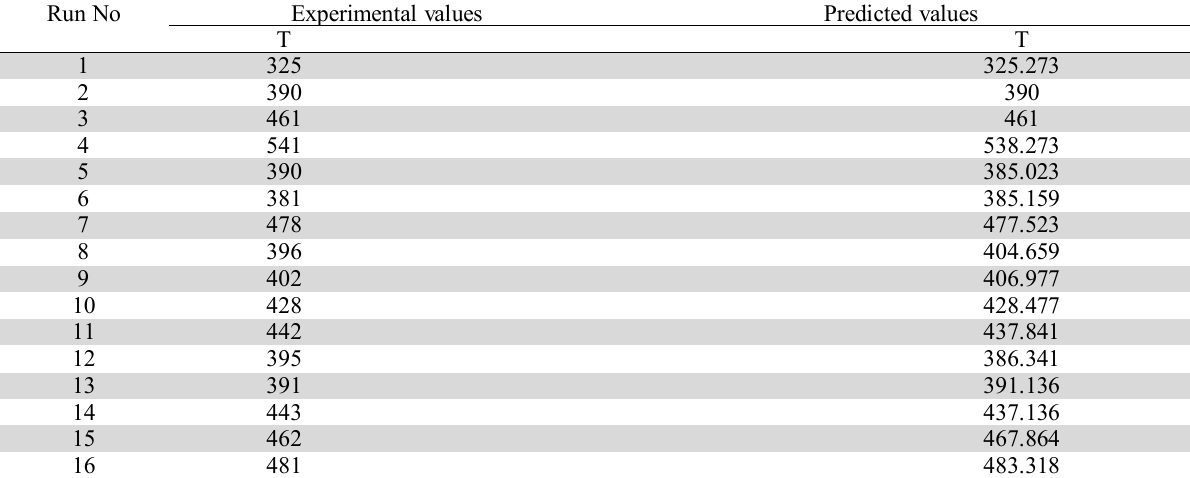
Experimental vs. predicted values for T